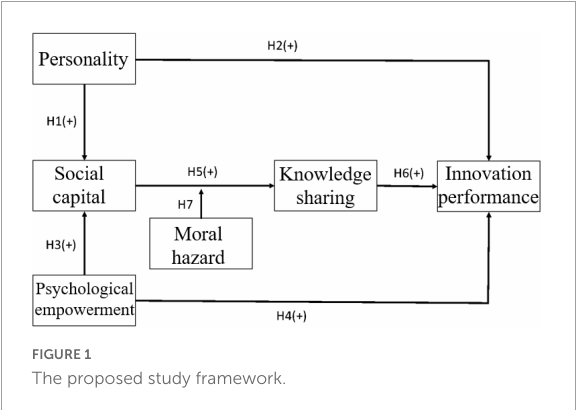
FIGURE1 The proposed study